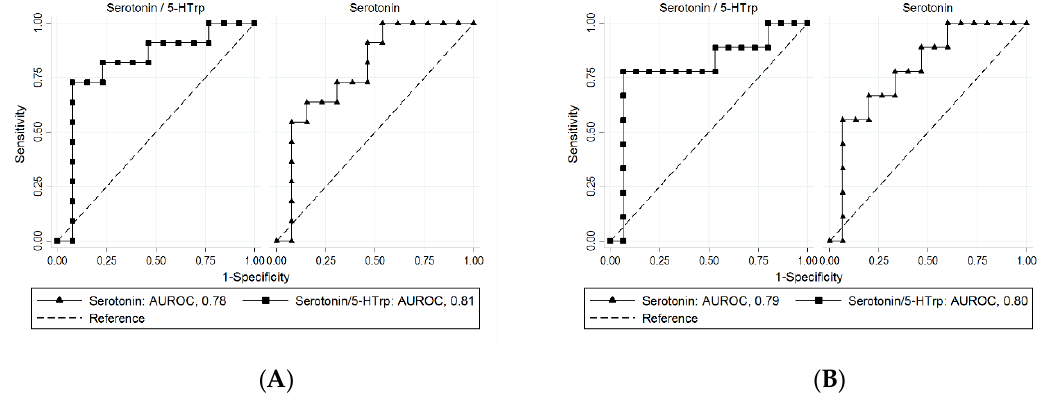
Figure 1. Performance of baseline serotonin and serotonin/5-HTrp ratio in predicting slow weight loss at: ( A ) three months and ( B ) six months after sleeve gastrectomy. AUROCs were calculated using amino acid metabolites proven to be significant (Table 3). Among the test metabolites, serotonin and serotonin/5-HTrp ratio showed superior prognostic performance with the best discriminatory ability for predicting slow weight loss three and six months after sleeve gastrectomy. AUROC values included: serotonin, 0.78 (95% CI: 0.58 – 0.97) at three months and 0.79 (95% CI: 0.59 – 0.97) at six months; serotonin/5-HTrp ratio, 0.81 (95% CI: 0.61 – 1.00) at three months and 0.80 (95% CI: 0.58 – 1.00)